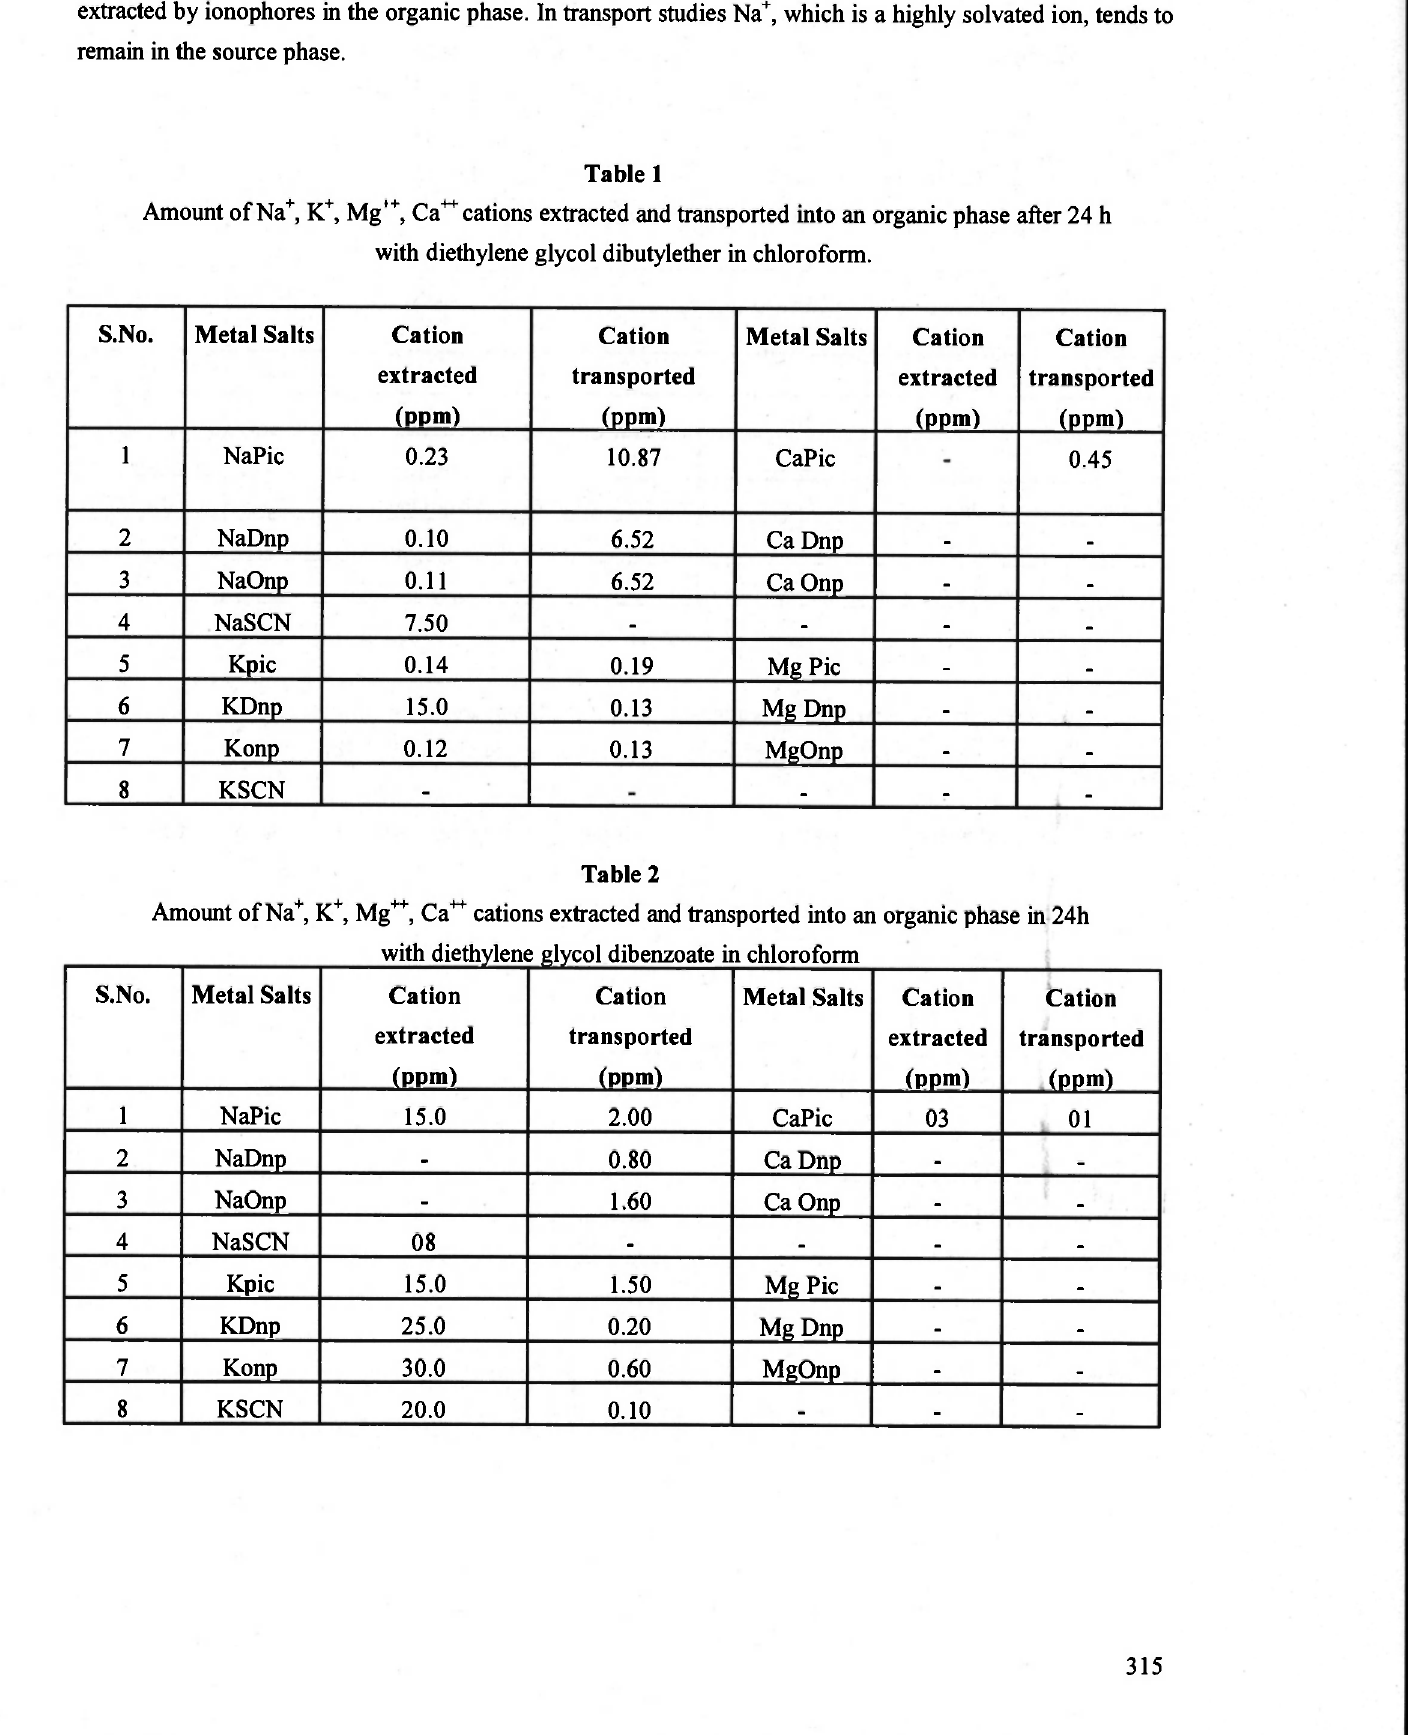
Amount of Na + , K + , Mg ++ , Ca^ cations extracted and transported into an organic phase in 24h with diethylene glycol dibenzoate in